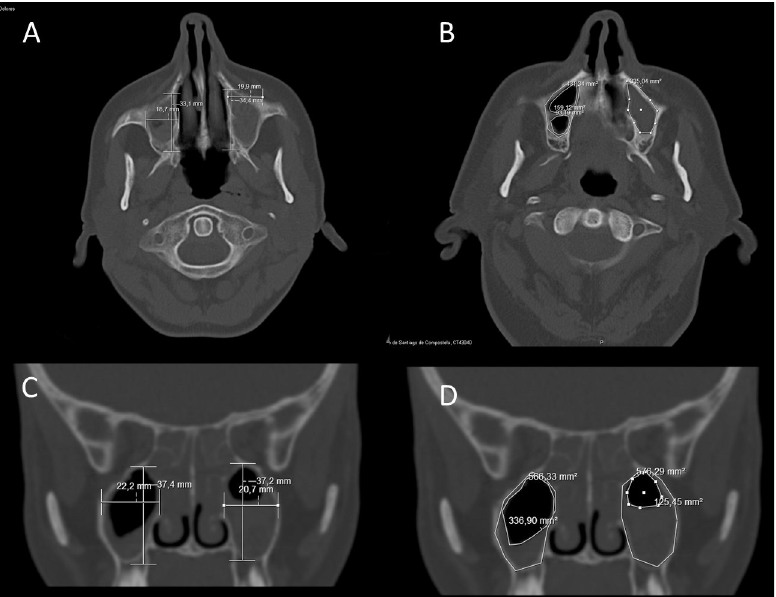
Fig 1. Representation of the measurements taken. A) Antero-posterior and medial-lateral length in the horizontal plane. Measurements taken at 5-10-15-20 mm from the palate plate or vault towards the cranial. B) Area of sinus contour, unoccupied area and affected area in the horizontal plane, at 5-10-15-20 mm cranially. C) Sinus height and width measured in the frontal plane. D) Area of sinus contour, unoccupied area and affected area in the frontal plane.